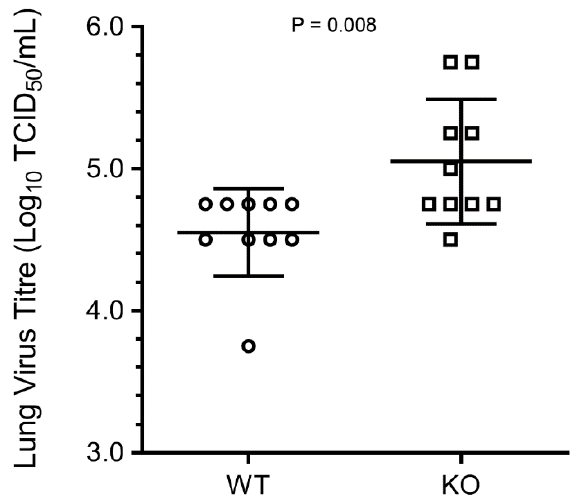
Figure 3. IAV progeny virus titre is higher in HDAC6 KO mouse lungs. The WT and KO male mice were inoculated intranasally with 150 pfu of PR8. After 5 days, the lungs were collected, homogenised, and virus titres were measured as 50% tissue culture infectious dose (TCID 50 ) in MDCK cells according to the method of Reed and Muench. The error bars represent the means ± standard deviation with 95% confidence interval ( n = 10 each). The p value was calculated by the unpaired two-tailed t -test.